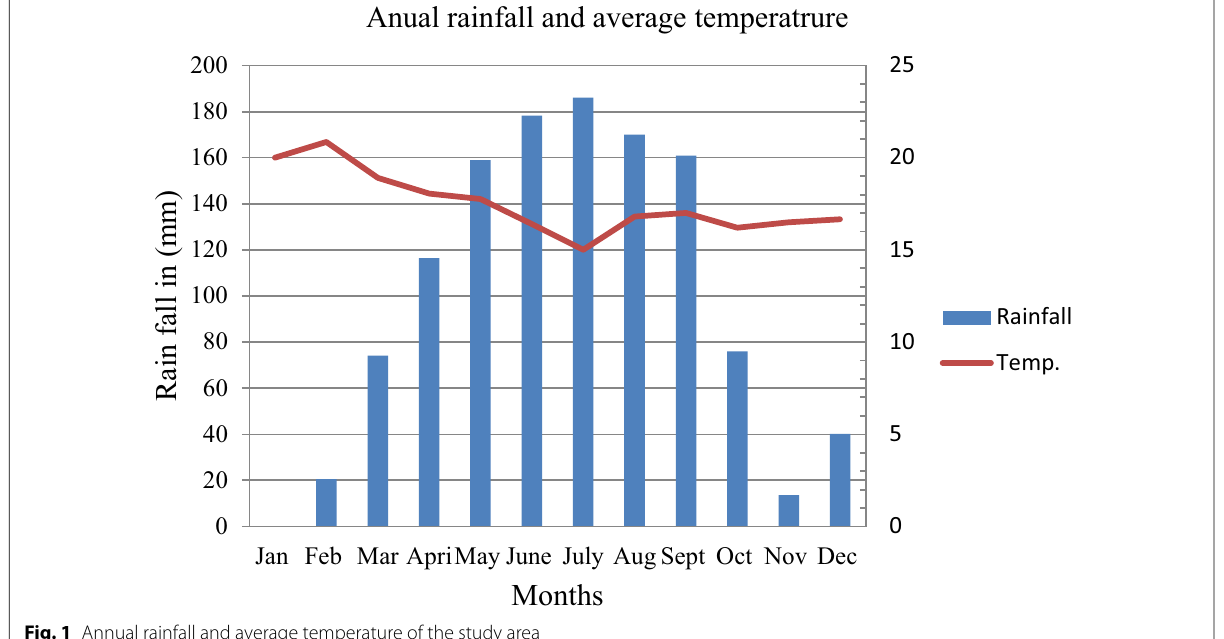
Fig. 1 Annual rainfall and average temperature of the study